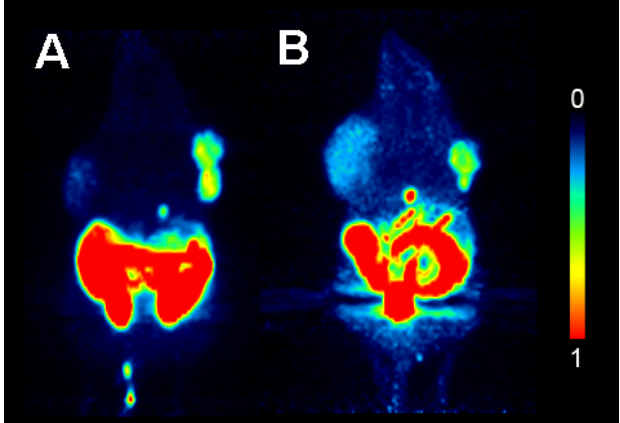
(60–90 min p.i.) performed with HEK293 control tumor bearing mice (left shoulder) and HEK293TK+ (right shoulder) xenografts. ( A ) Mouse (24.3 g) injected with [ 18 F]FHBG (17.98 MBq); ( B ) Mouse (28.4 g) injected with HHB-5-[ 18 F]FEP (8.47